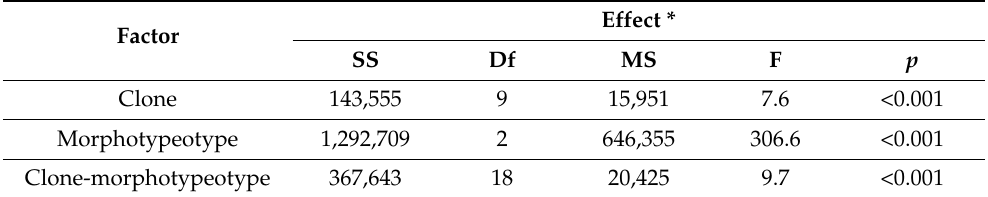
Table 5. The results of the two-way variant analysis (F-test) of the influences of clones and months